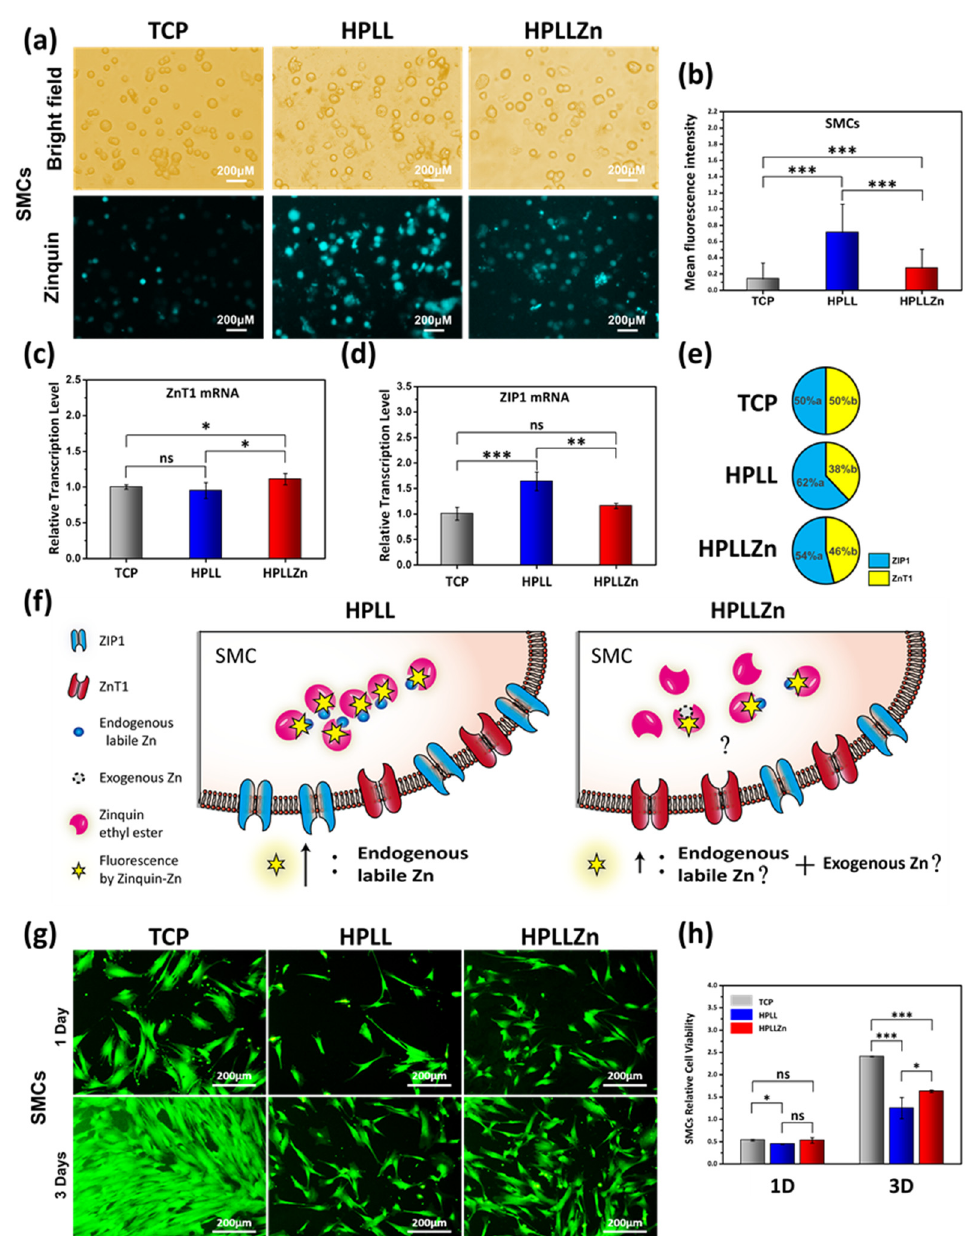
Figure 4. ( a ) Zinquin-Zn fluorescence in smooth muscle cells after contact with different coatings. ( b ) Semi-quantitative statistics of the mean fluorescence intensity (MFI) of Zinquin. The relative transcription level of mRNA is related to the Zn ion channel, ( c ) ZnT1 for efflux of the Zn ion, and ( d ) ZIP1 mRNA for the influx. ( e ) The average relative ratio of the zinc channel mRNA transcription levels. ( f ) Schematics of the sources of the fluorescent. ( g ) Rhodamine 123 fluorescence images of SMCs’ growth and ( h ) the cell viability after incubation for 1 day and 3 days (TCP, tissue culture plate; data were analyzed using 1-way ANOVA, * p < 0.05, ** p < 0.01, *** p < 0.001; ns, not significant).